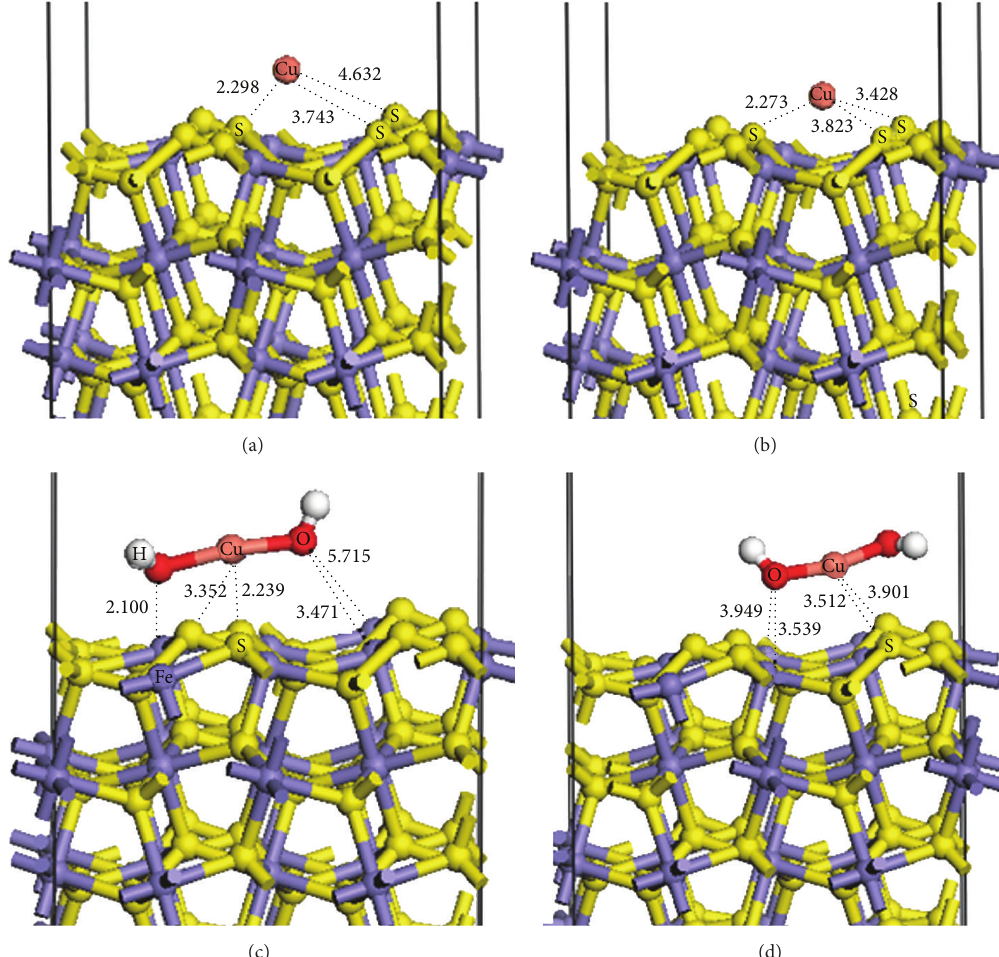
Figure 5: The possible adsorption sites of Cu 2+ and Cu(OH) 2 on the pyrite (100) surface. (a) The adsorption of Cu 2+ on the top site; (b) the adsorption of Cu 2+ on the hollow site; (c) the adsorption of Cu(OH) 2 on the top site; (d) the adsorption of Cu(OH) 2 on the hollow site.